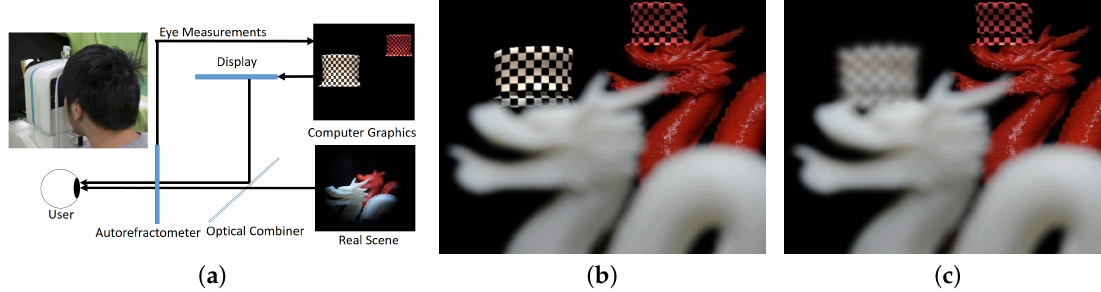
Figure 1. EyeAR aims to embed computer graphics (CG) objects into the real world that are indistinguishable from real objects. ( a ) schema of the EyeAR concept: we measure the user’s pupil size and accommodative state and then feed these values into a real-time ray tracer that generates matching CG that is displayed via a half-mirror. In an example application, we augment real dragon statues with virtual hats of the same color; ( b ) conventional optical see-through displays exhibit a Depth of Field (DoF) mismatch between CG and the real scene. Note how the white hat is in focus, while the white dragon is blurred; ( c ) EyeAR accurately matches the DoF of virtual objects, correcting this